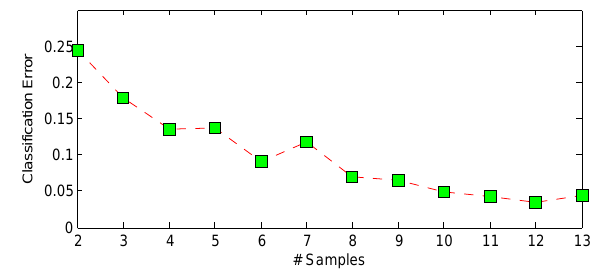
Figure 2: Average classification error as function of the number of training